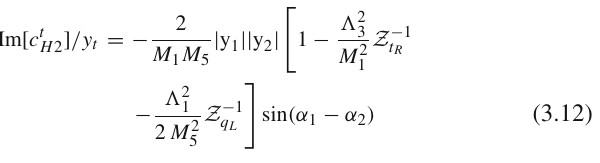
Fig. 3 BoundsontheimaginarypartsoftheWilsoncoefficients, to the electron EDM of only one operator at a